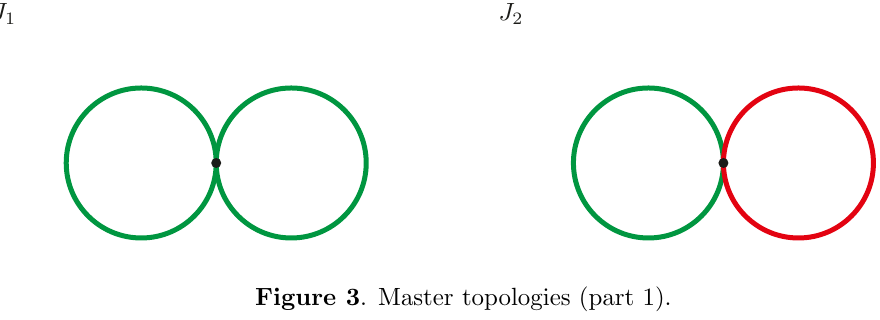
Figure 3 . Master topologies (part 1).